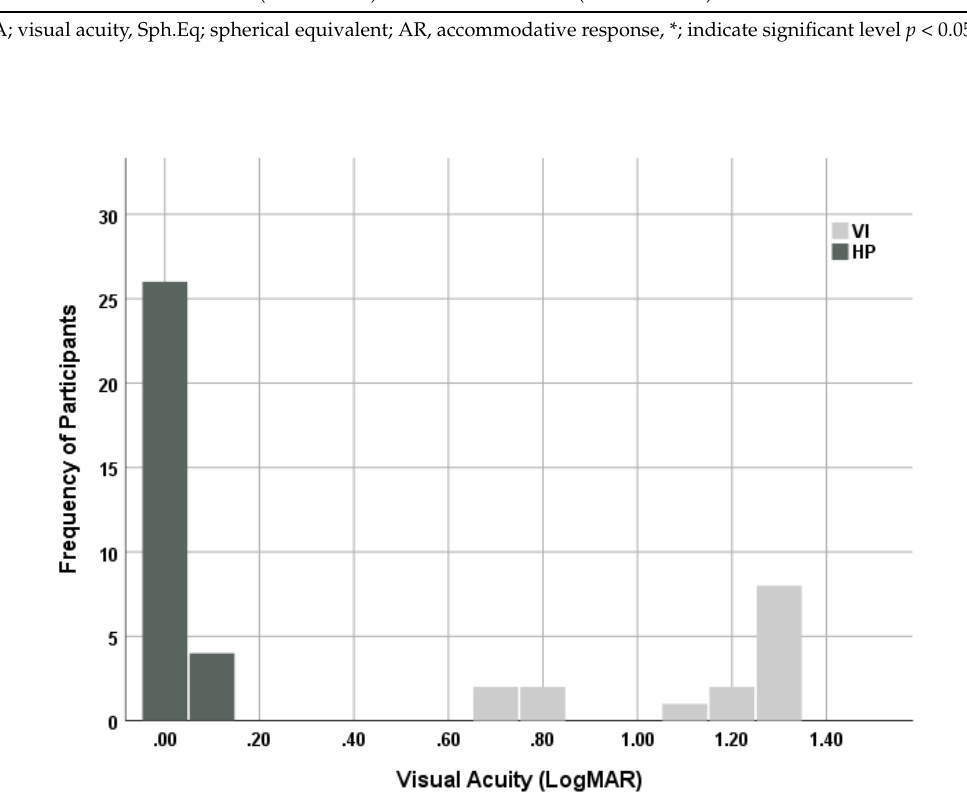
Figure 1. Illustration of the distribution of visual acuity of both visual impairment group (VI) and participants with healthy vision (HP).